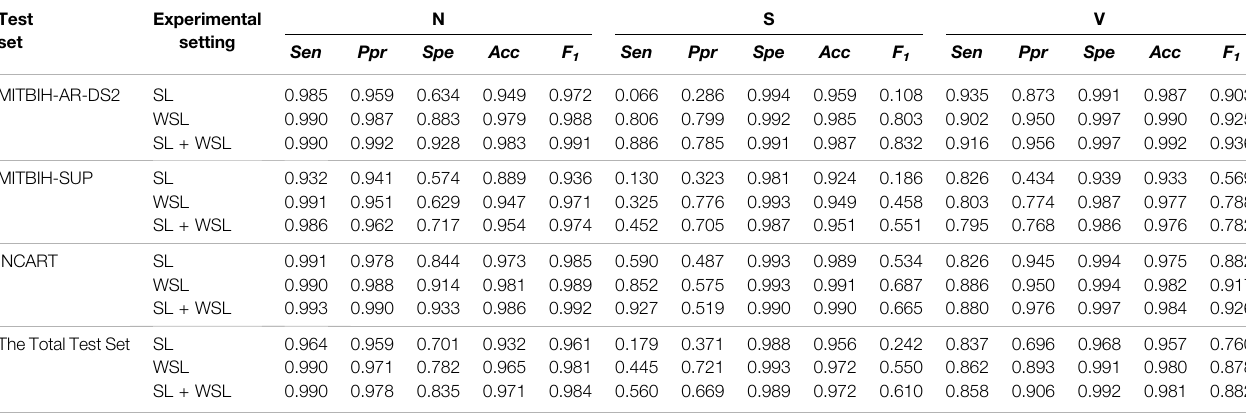
TABLE 3 | Experimental results of different training setting on the evaluation datasets. Test set